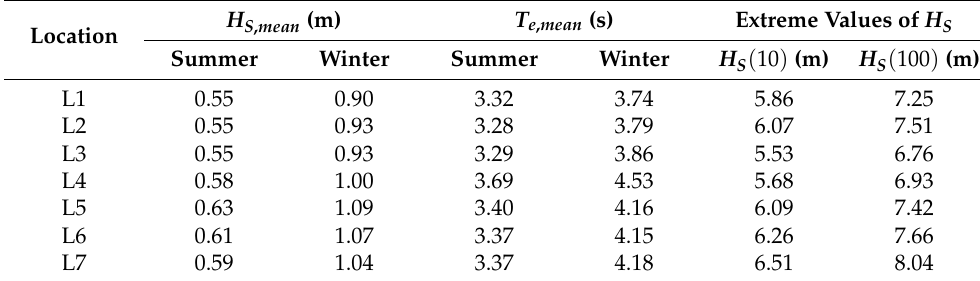
Table 3. Wave climate of the selected locations for two seasons: winter and summer. Reproduced with permission from